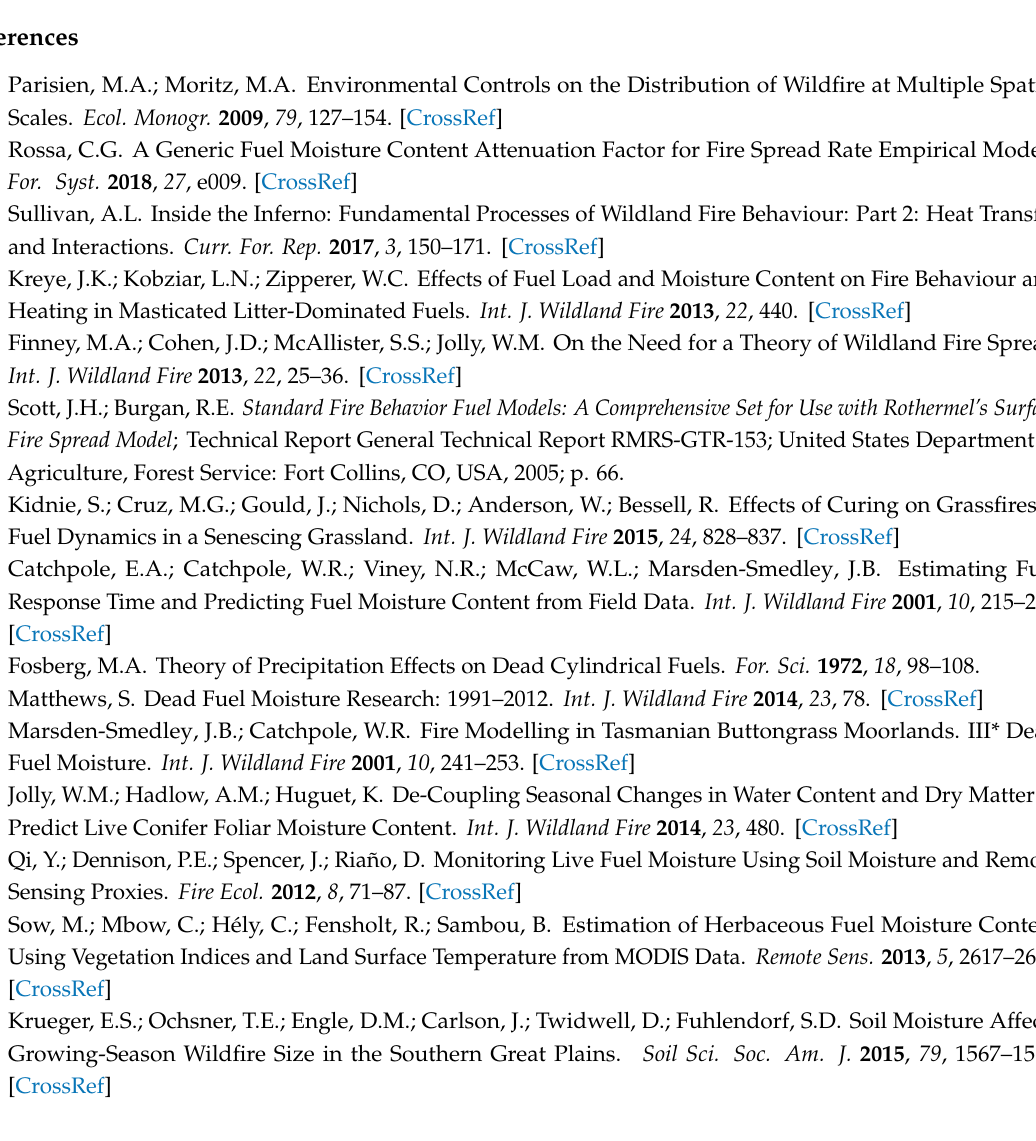
Figure A3. Regardless of species and plant matter type, bulk density was similar across grassland fuel samples and had a mean value of 0.072 g/cm 3 . BRIN = Bromus inermis , POPR = Poa pratensis